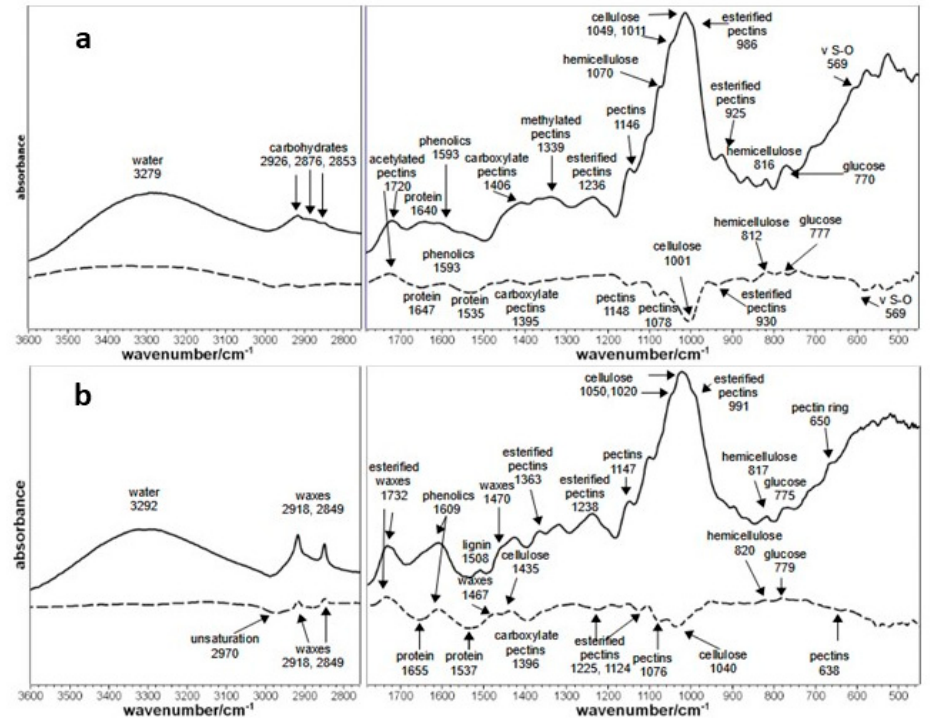
Figure 4. ATR/IR spectra of the kiwifruit pulp ( a ) and peel ( b ). The continuous lines represent the treated fruits IR spectra, while the dashed lines represent the difference spectra between the treated and the reference